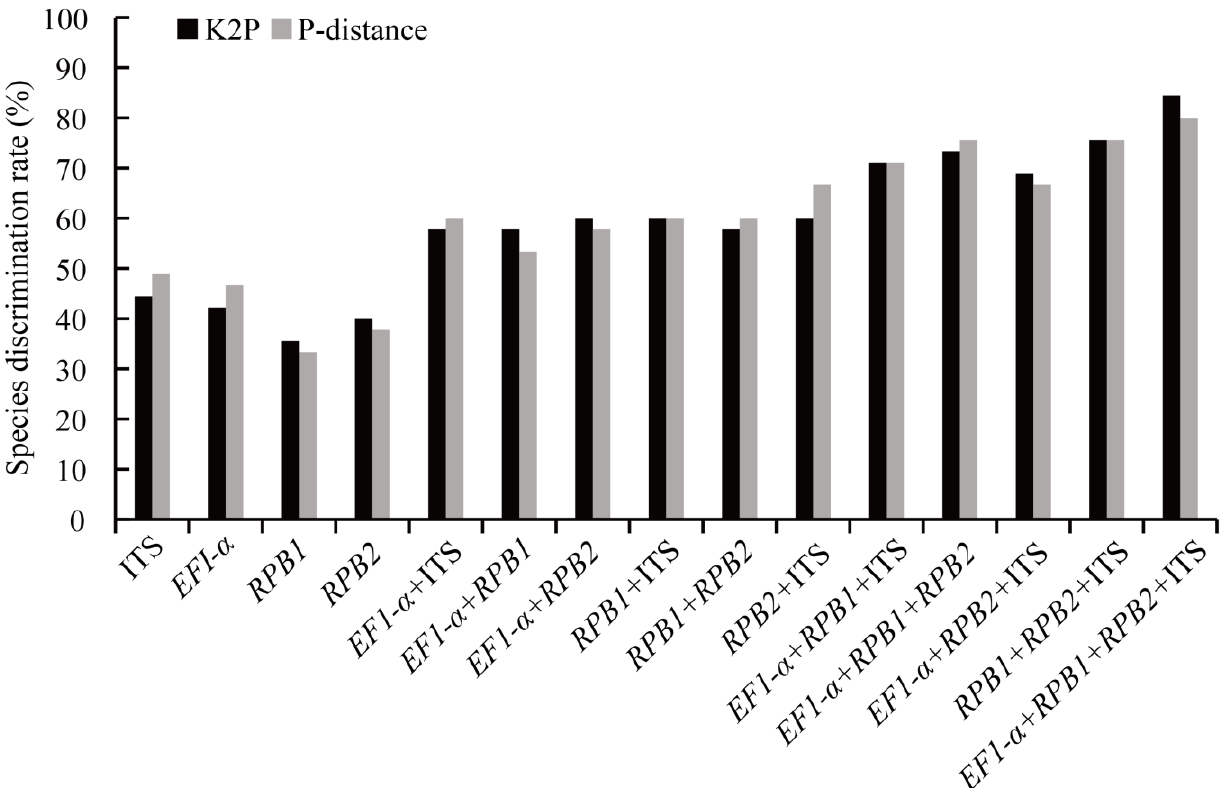
Figure 4. Species discrimination rate based on K2P and P-distance models in the NJ-tree approach. Sequences included all tested 4 single and 11 combined DNA fragments in Morchella . Histograms of the frequencies ( y -axes) of the species discrimination rate based on K2P (black bars) and P-distance (gray bars); x -axes represent single- and multi-locus barcodes in Morchella .